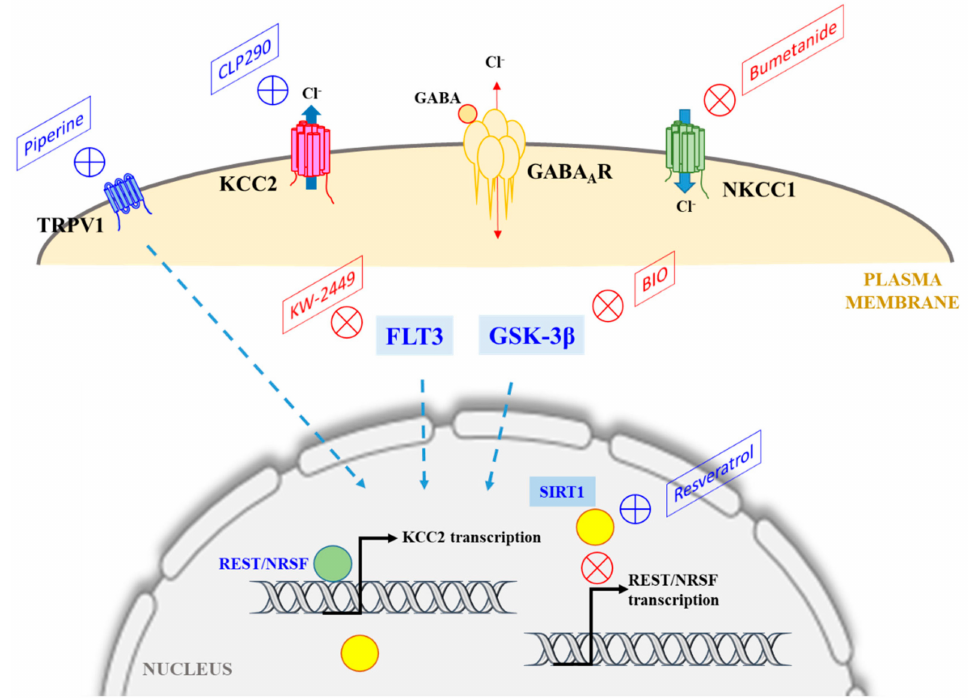
Figure 1. A schematic diagram illustrating the major chloride transporters KCC2 and NKCC1, whose activitiesdetermineintracellularCl − concentrationandEGABA,andthepharmacologicalmanipulations that could potentially correct for a loss of KCC2 levels or activity under neuropathological conditions (where GABAergic transmission could become excitatory instead of inhibitory). The classical NKCC1 antagonist bumetanide has been shown to be e ffi cacious in this regard. As discussed in the text, CLP290 enhances the plasma membrane expression of KCC2, while compounds that target TRPV1, FLT3, or GSK-3 β also modulates KCC2 expression (dotted arrows), but the mechanisms involved are unclear. Resveratrol activation of SIRT1 could downregulate the expression of RE1-silencing transcription factor / Neuron-restrictive silencer factor (REST / NRSF), which suppresses KCC2 expression. See text for more